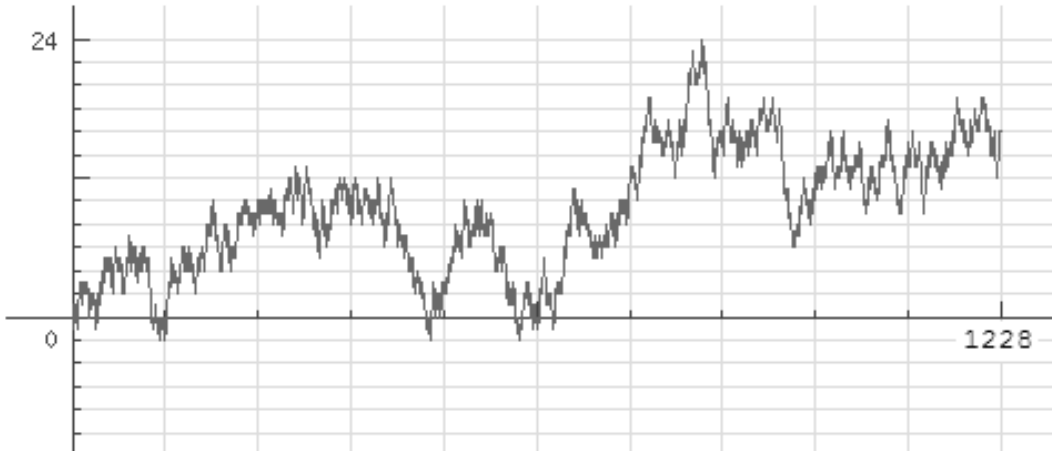
Figure 1: Partial sums of the sequence N s − s − 1 , s odd prime